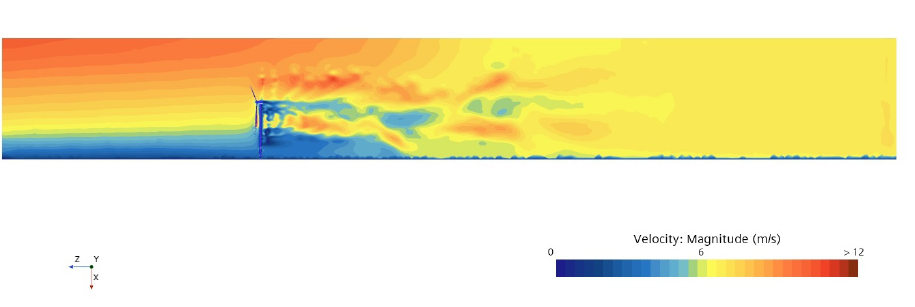
Figure 14. Scalar scene velocity: